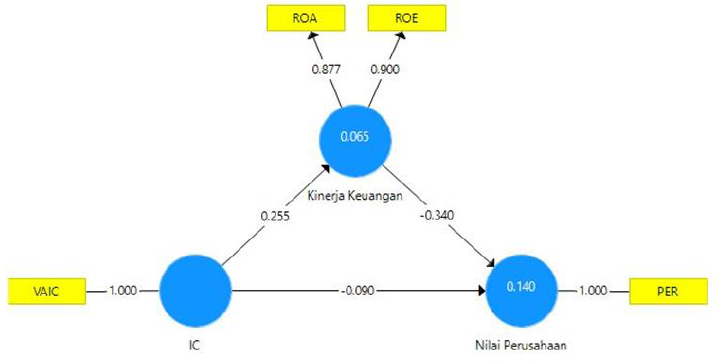
Figure 1 : The result of PLS Algorithm test